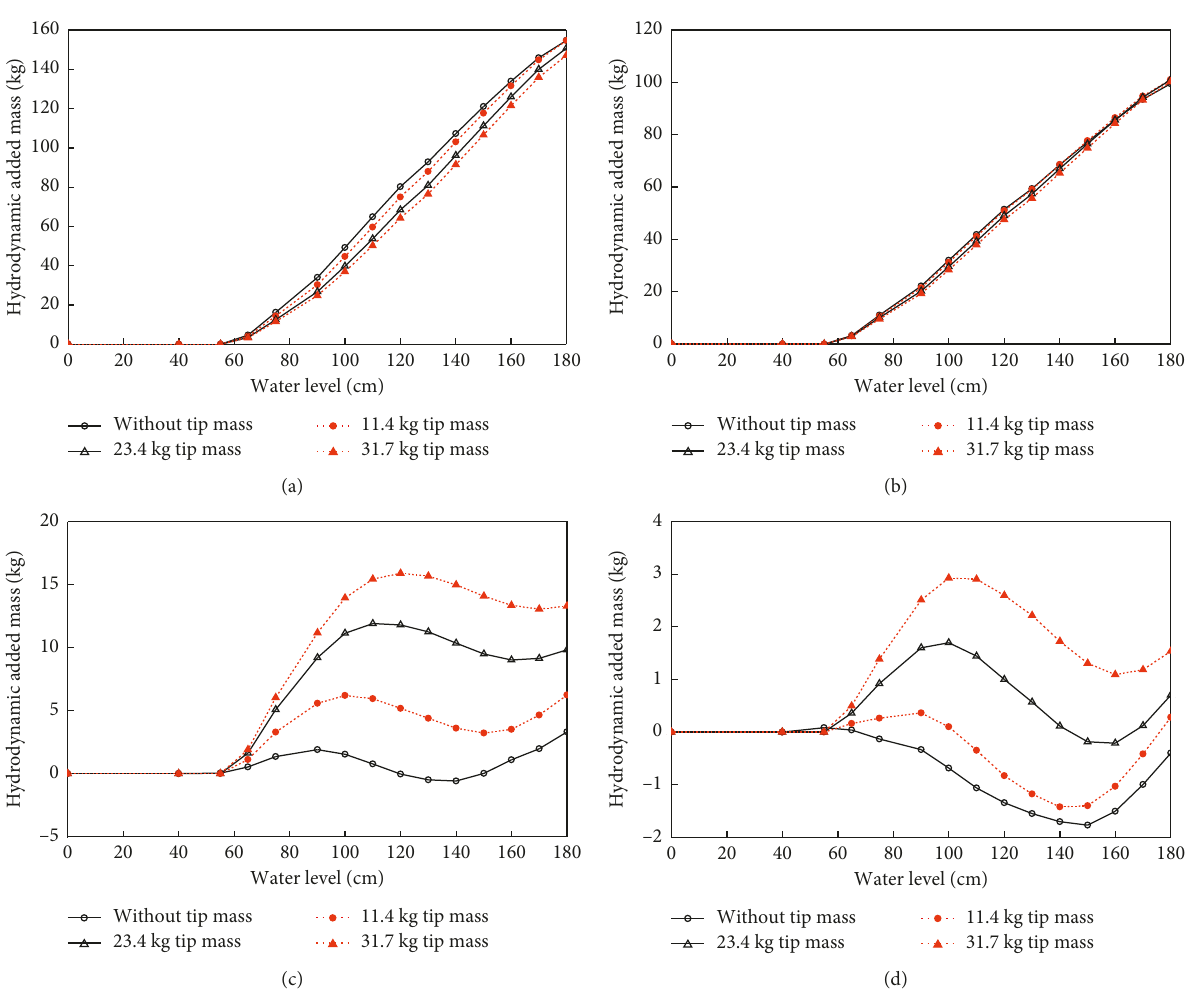
Figure 12: MHAM of the specimen for the four tip masses in case III as a function of water level, corresponding to (a) first mode along the x -axis; (b) first mode along the y -axis; (c) second mode along the x -axis; and (d) second mode along the y -axis.